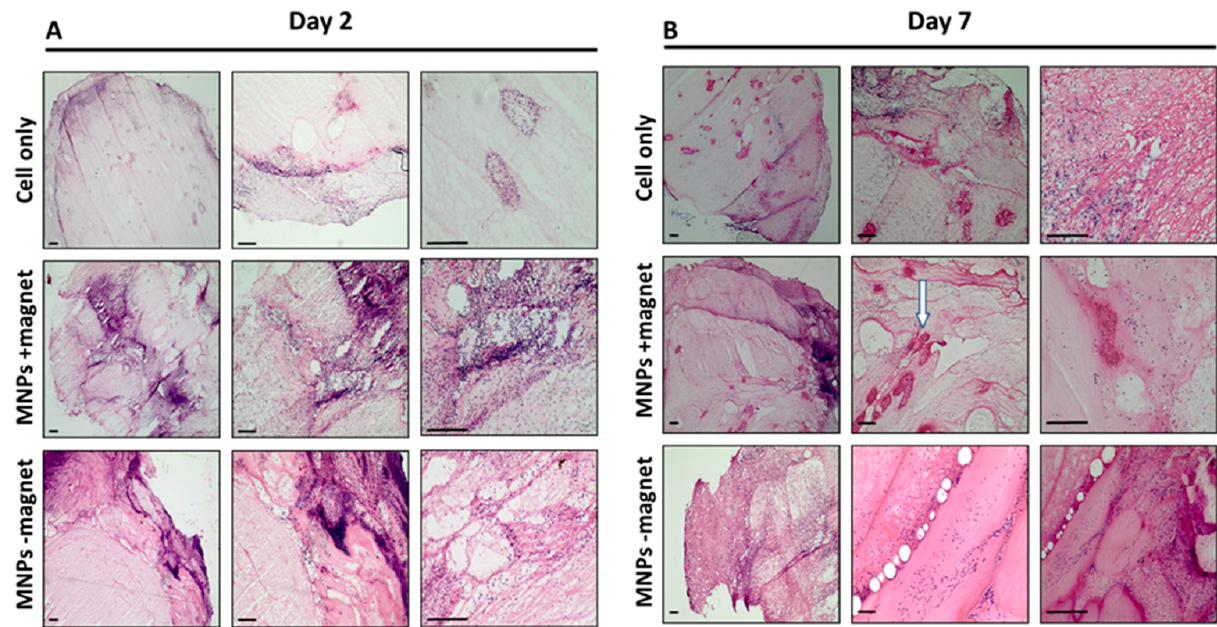
Figure 4. H&E staining of extracted hydrogel constructs at increasing magnification for all groups (cell only, MNPs +magnet, MNPs − magnet) at day 2 ( A ) and day 7 ( B ). Cell nuclei depicted by purple staining and extracellular matrix by pink staining. White arrow showing the pockets of cell accumulation. Scale bar = 100 µ